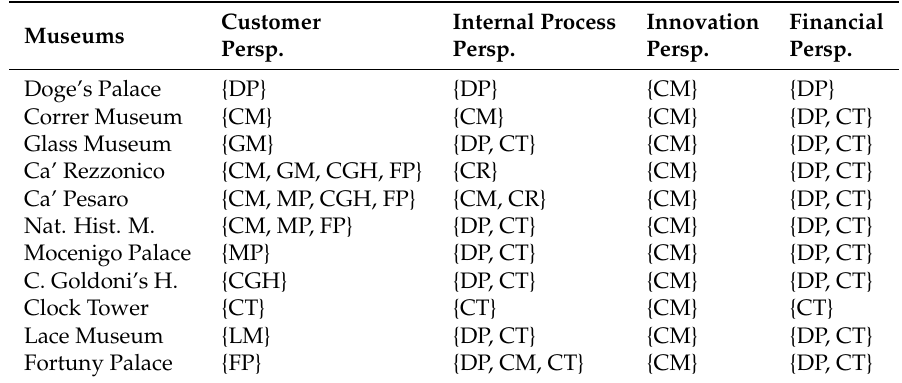
Table 8. Reference sets of the MUVE museums obtained by the first stage DEA-BSC models for the four